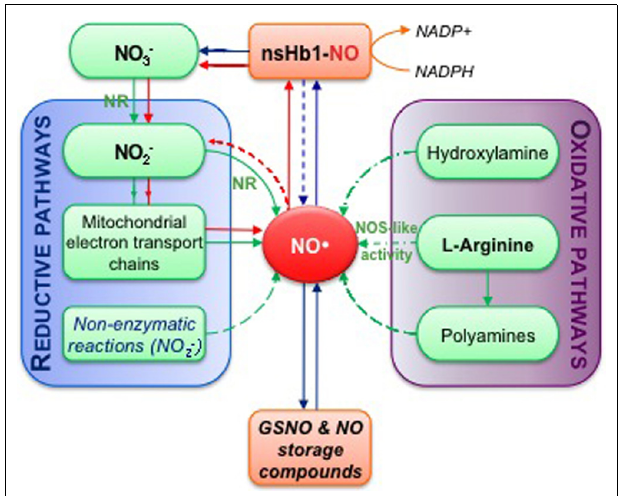
FIGURE 4 | Simplified overview of NO biosynthesis and homeostasis in plant cells. This scheme is inspired from Moreau etal. (2010). Nitrate ( NO − 3 ) assimilation produces nitrite ( NO − 2 ) in a reaction catalyzed by nitrate reductase (NR).The subsequent reduction of nitrite into NO can occur enzymatically, either through NR activity or mitochondrial electron transport chains, and via non-enzymatic reactions (reductive pathways). Alternatively, NO synthesis can result from oxidative reactions from hydroxylamine, polyamines or L -arginine ( L -Arg; oxidative pathways). NO synthesis from L -Arg could account for the nitric oxide synthase-like (NOS-like) activity detected in plants.The pool of NO is then influenced by non-symbiotic hemoglobin 1 (nsHb1) dioxygenase activity, which converts NO into NO − 3 . NO can also react with reduced glutathione or thiol groups leading to the reversible formation of S -nitrosothiols (e.g., GSNO, S -nitrosoglutathione; S -nitrosylated proteins). Red arrows highlight the so-called nitrate-NO cycle that may take place under hypoxia. Green arrows correspond to biosynthesis reactions while blue arrows indicate reactions involved in NO